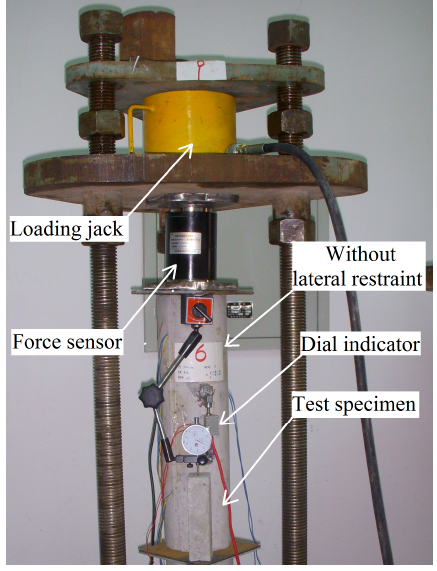
Figure 3. Example of a creep test on the specimen without lateral restraint. Table 6. Summary of the experimental design on 12 concrete-filled steel tube (CFST) specimens.